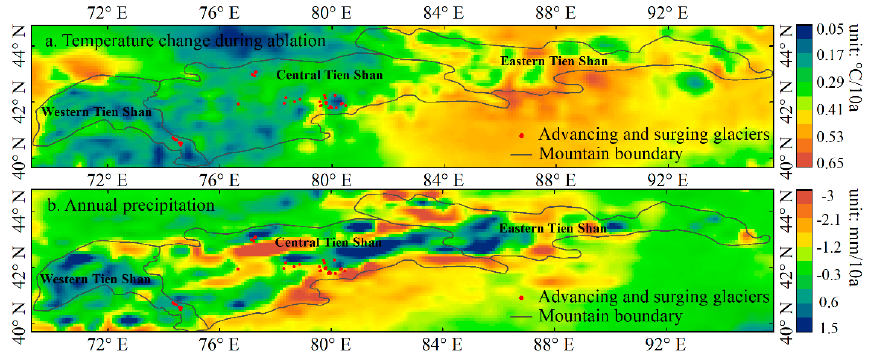
Figure 13. Heat maps show ( a ) the change in temperature during ablation and ( b ) annual precipitation in the Tien Shan Range from 1990 to 2019 (data from ERA5-Land Climate Reanalysis dataset).